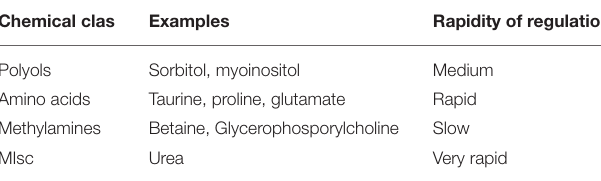
TABLE 1 | Features of organic